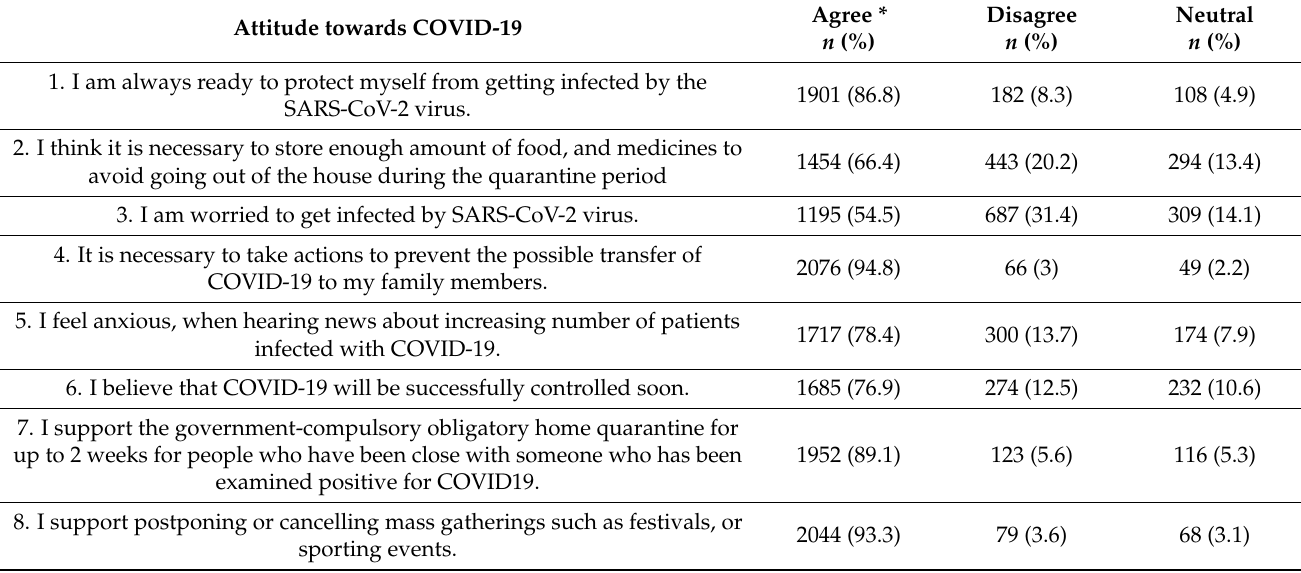
Table 3. Attitude of the survey population towards COVID-19.